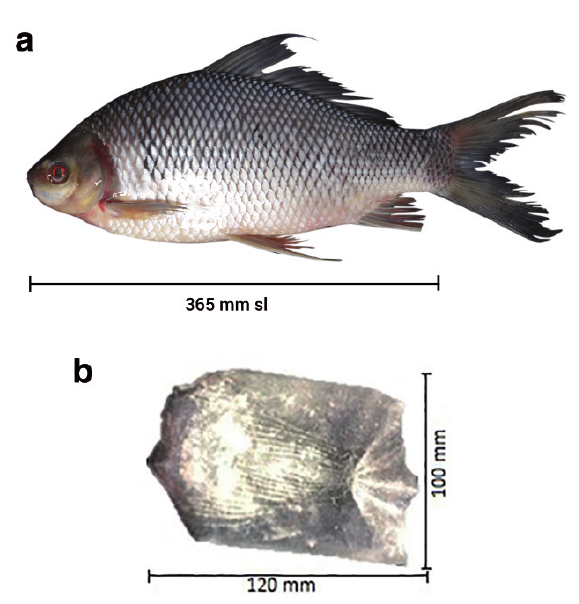
Figure 2. ( a ) Kelabau ( O. melanopleurus ) and ( b ) ctenoid scale of O. melanopleurus